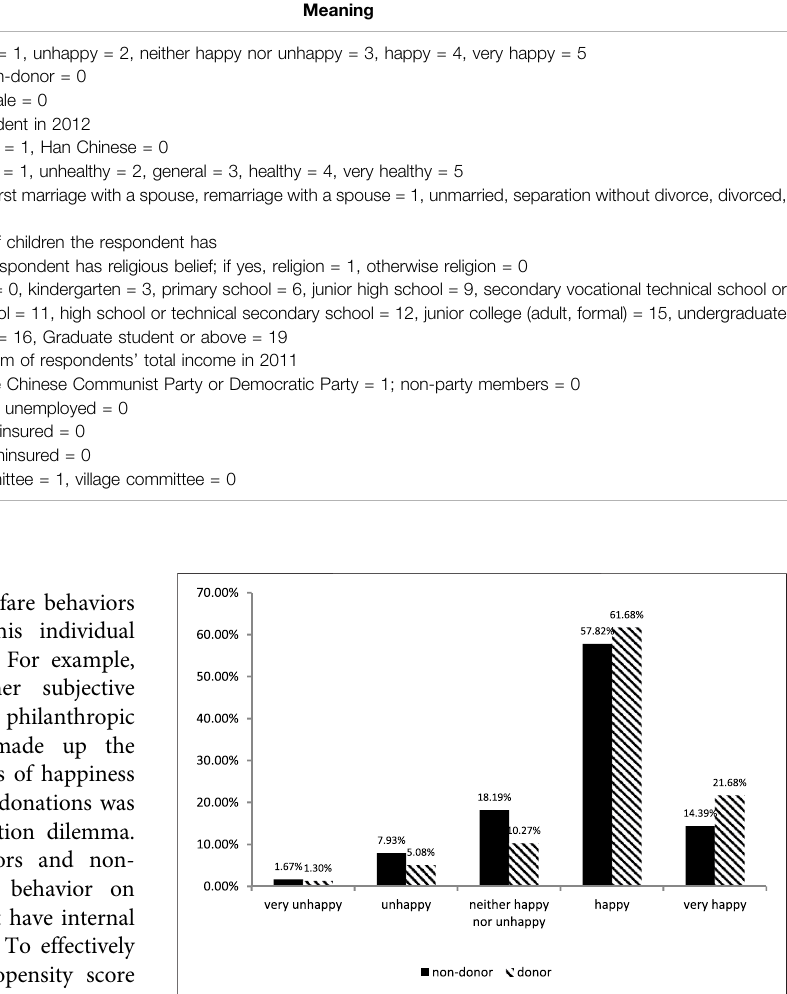
FIGURE 1 | Distribution of happiness based on CGSS 2012